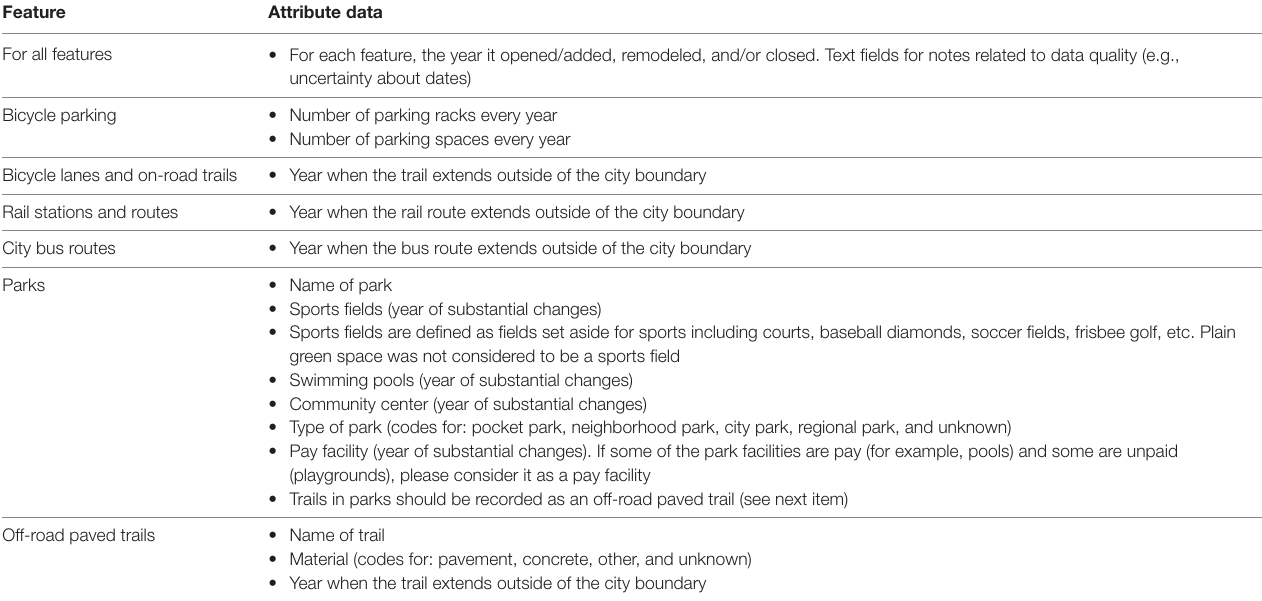
tABLe 3 | Attribute data collected for each feature change of a substantial